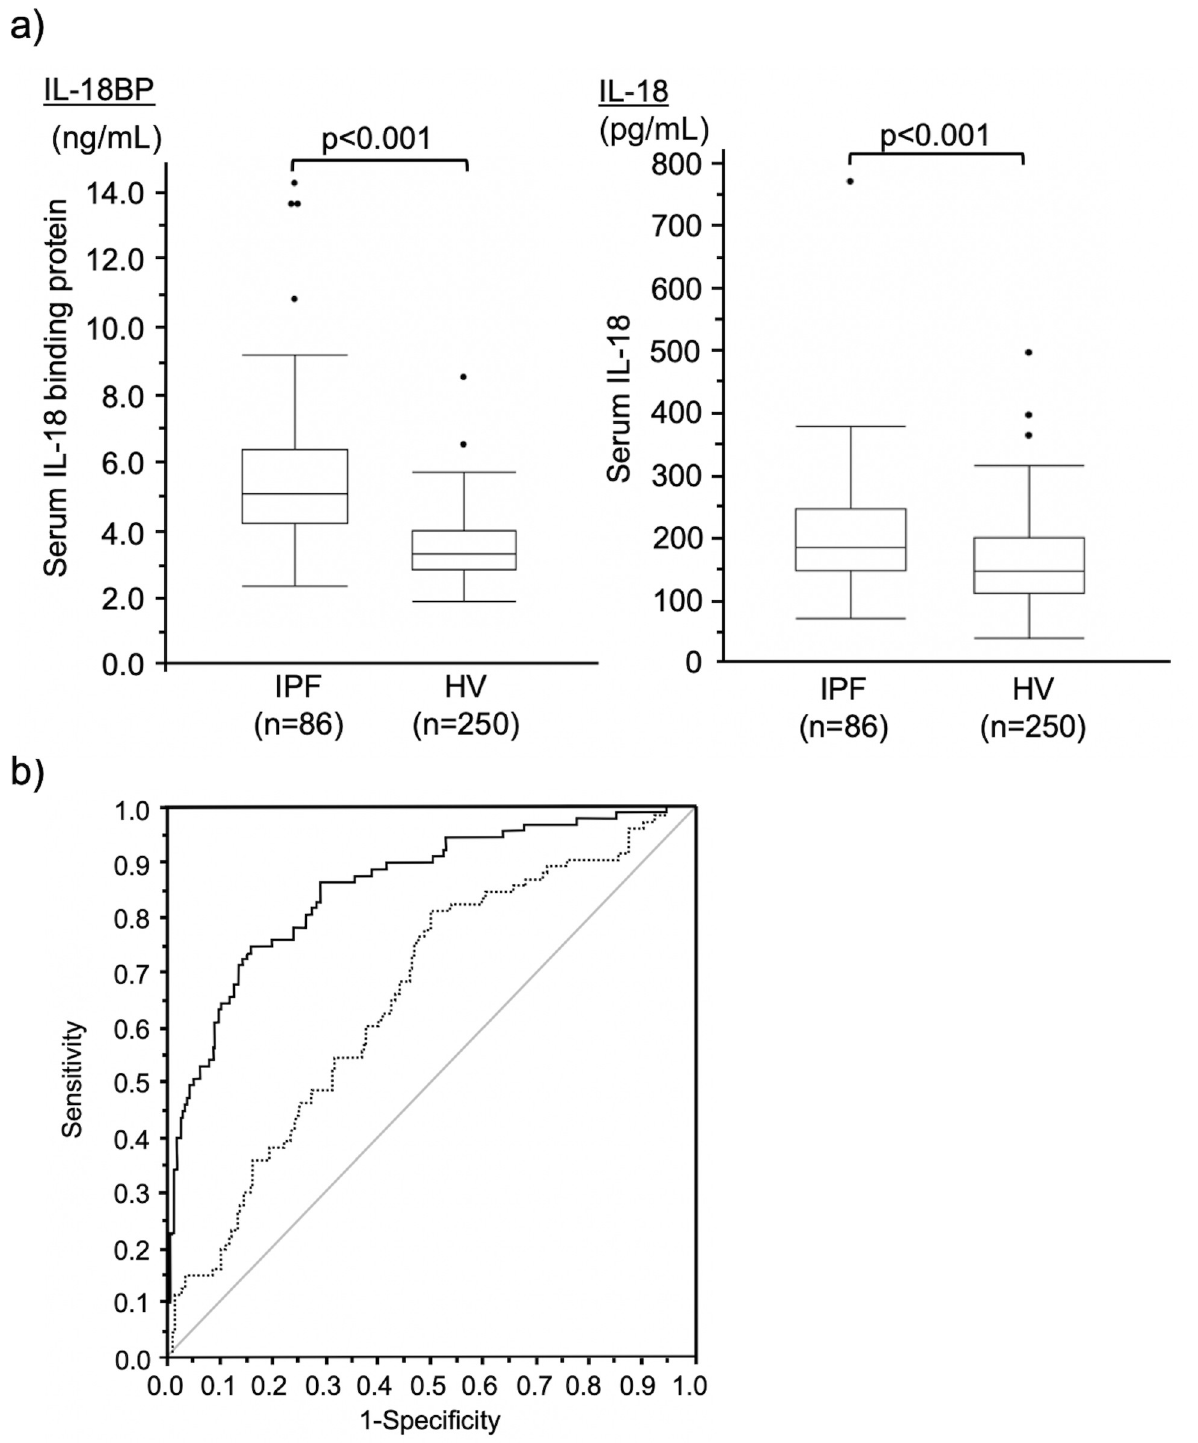
Fig 2. Distribution of serum IL-18BP concentrations and ROC analysis in IPF patients and HVs. (a) Box plot graphs showing ranges of serum IL- 18BP and IL-18 levels in patients with IPF and HVs. The median IL-18BP levels of serum in patients with IPF and HVs were 5.06 (4.20–6.35) ng/mL and 3.31 (2.84–3.99) ng/mL (p < 0.001). The median IL-18 levels of serum in patients with IPF and HVs were 181.7 (146.6–243.6) pg/mL and 143.9 (108.5–196.8) pg/mL, respectively (p < 0.001). Boxes represent the 25th–75th percentiles; solid lines within the boxes show the median values, whiskers are the 10th and 90th percentiles, and the small dots represent outliers. (b) ROC curve analyses for serum IL-18BP (solid line) and IL-18